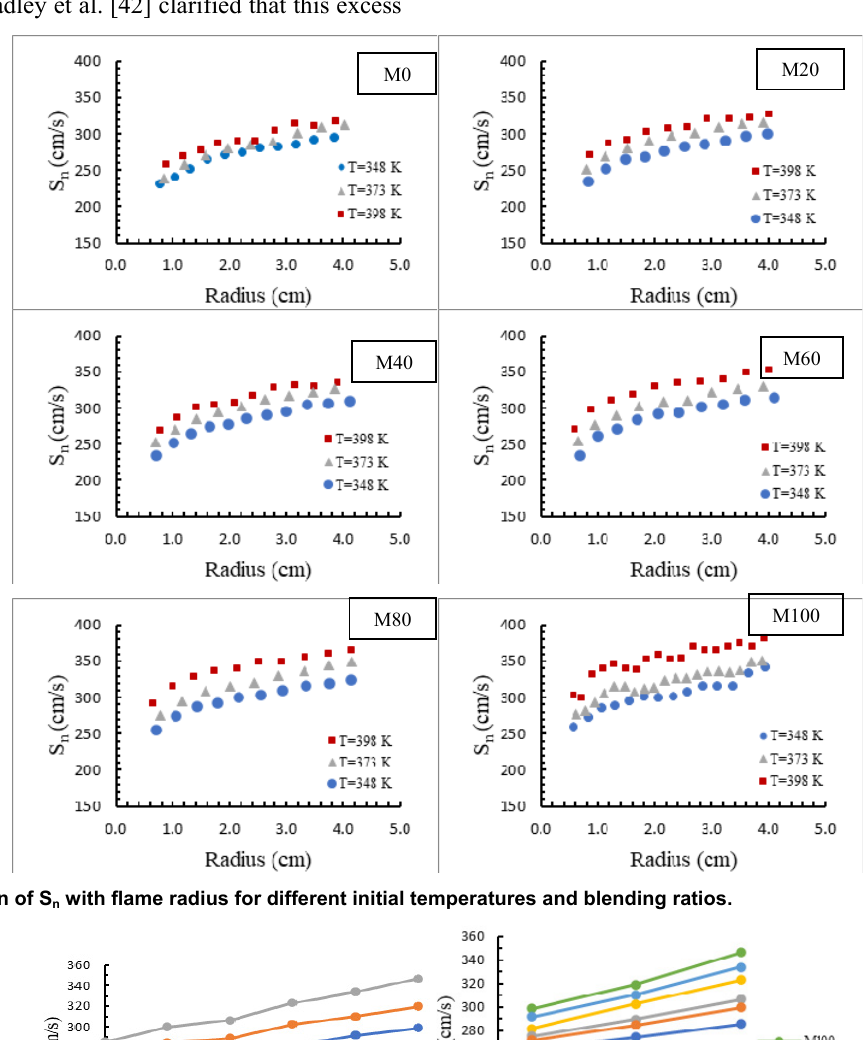
Figure 8. Variation of S n with flame radius for different initial temperatures and blending ratios.